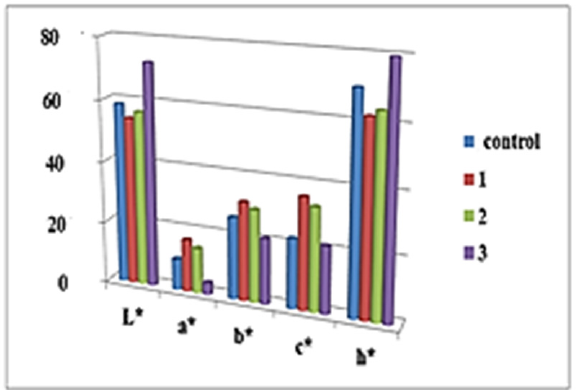
Figure 1. Color indicators of sponge cake crust with elderberry blossom flour ( Sambucus nigra L.).